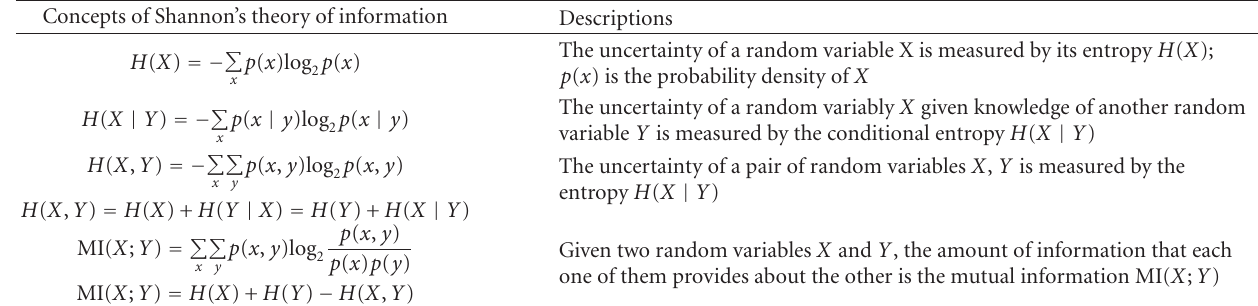
Table 1: Concepts of entropy and MI defined by Shannon’s theory of information.